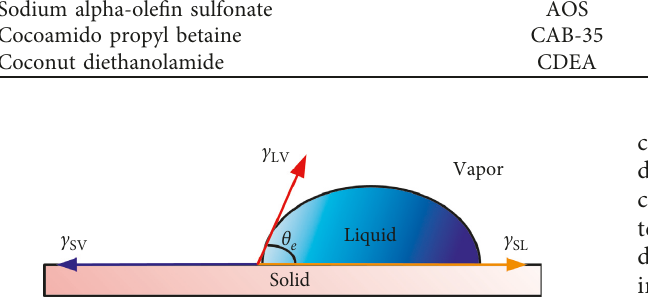
Figure 1: The relationship between the contact angle and solid– liquid, solid–vapor, and liquid–vapor surface tension.